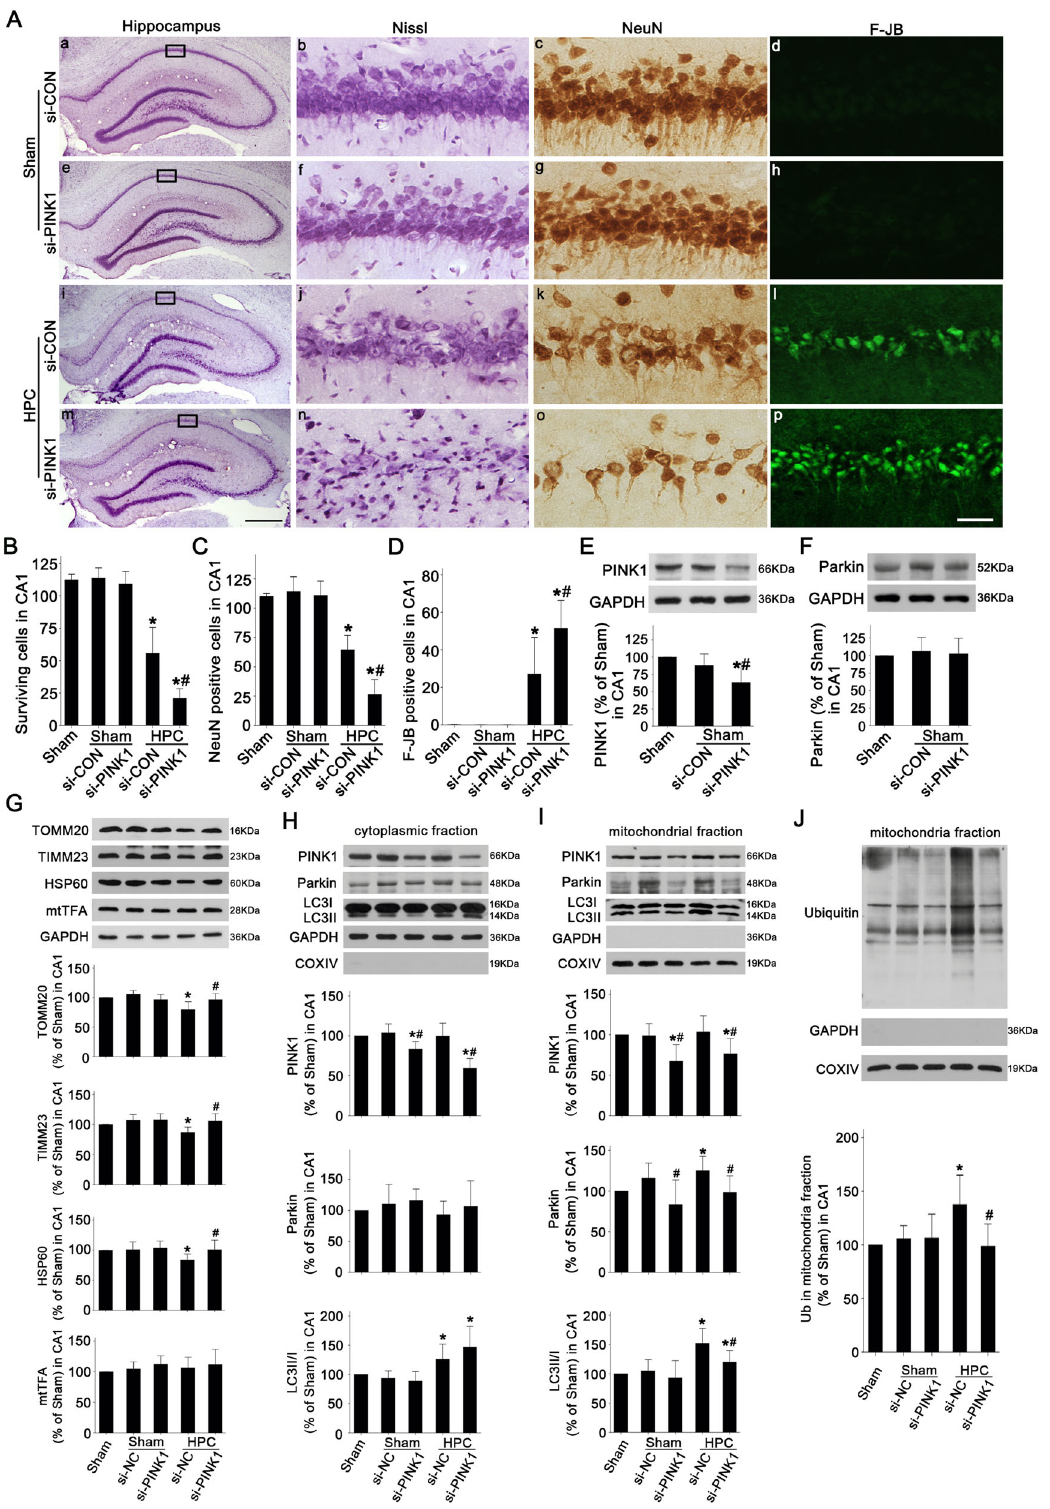
animal-related experiments were operated on the basis of the Animal Research: Reporting in vivo Experiments (ARRIVE) guidelines and were supervised by the Animals Care and Use Committee of Guangzhou Medical University (Guangzhou, China). All animals were housed in a temperature- controlled (21 – 23 °C) and 12-h light/dark cycle environment with ad libitum water and food. Every effort was made to minimize the number